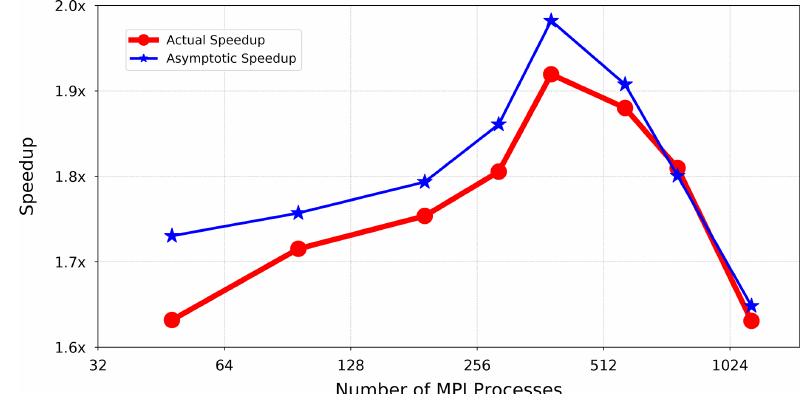
Figure 7. The red curve shows the methodical speedup of ECHAM6 using the concurrent radiation scheme. The blue curve shows the methodical speedup that the model would achieve